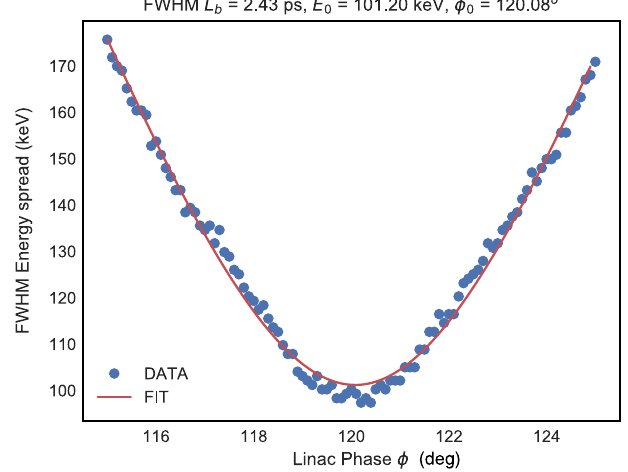
FIG. 41. Data and fit from a typical linac phase scan.